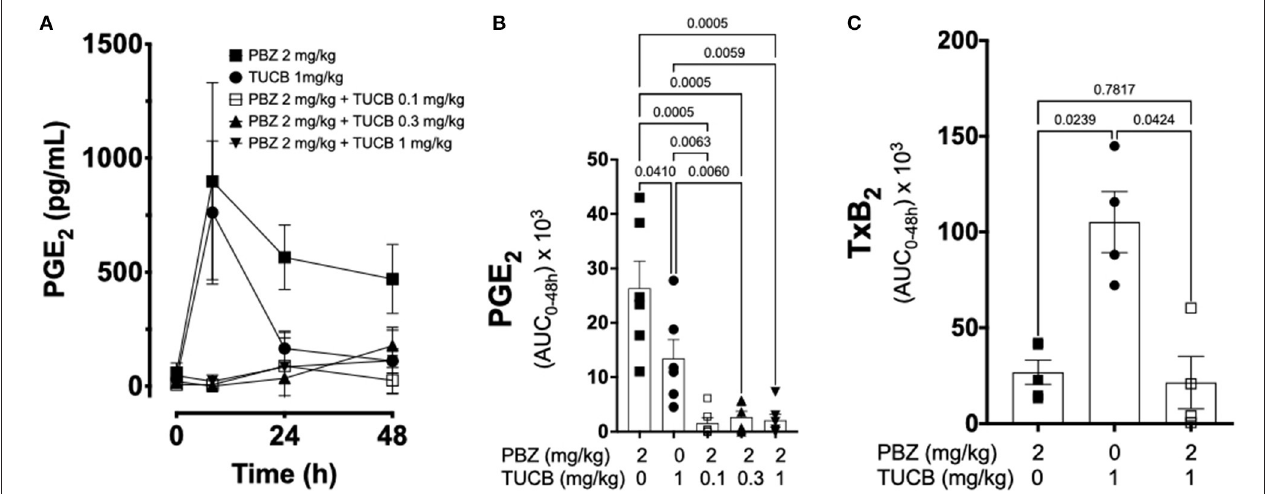
FIGURE 3 | Effect of soluble epoxide hydrolase (sEH) and cyclooxygenases (COX) inhibition on prostanoid response in joint fluid during synovitis. Forty-eight-hour time course (A) and aggregate area under curve (AUC) (B) for synovial fluid concentrations of prostaglandin (PG) E 2 , and thromboxane A 2 AUC (C) in an equine synovitis model induced by intra-articular injection of lipopolysaccharide (LPS; 3 µ g) into the radiocarpal joint ( n = 6 horses) as measured using ELISA techniques. Horses were treated intravenously with the sEH inhibitor trans -4-{4-[3-(4-Trifluoro-methoxy-phenyl)-ureido]-cyclohexyloxy}-benzoic acid (TUCB), the non-selective COX inhibitor phenylbutazone (PBZ) or both, at the indicated doses marked below the graphs, at the same time as the intra-articular LPS injection. For graph (A) data are shown as mean ± SEM. For graphs (B,C) data are shown as individual values (symbols) and mean ± SEM (columns), and p -values are shown above each respective comparison [Friedman test (B) ; Mixed-effects model (C) ; Corrected for multiple comparisons by controlling the False Discovery